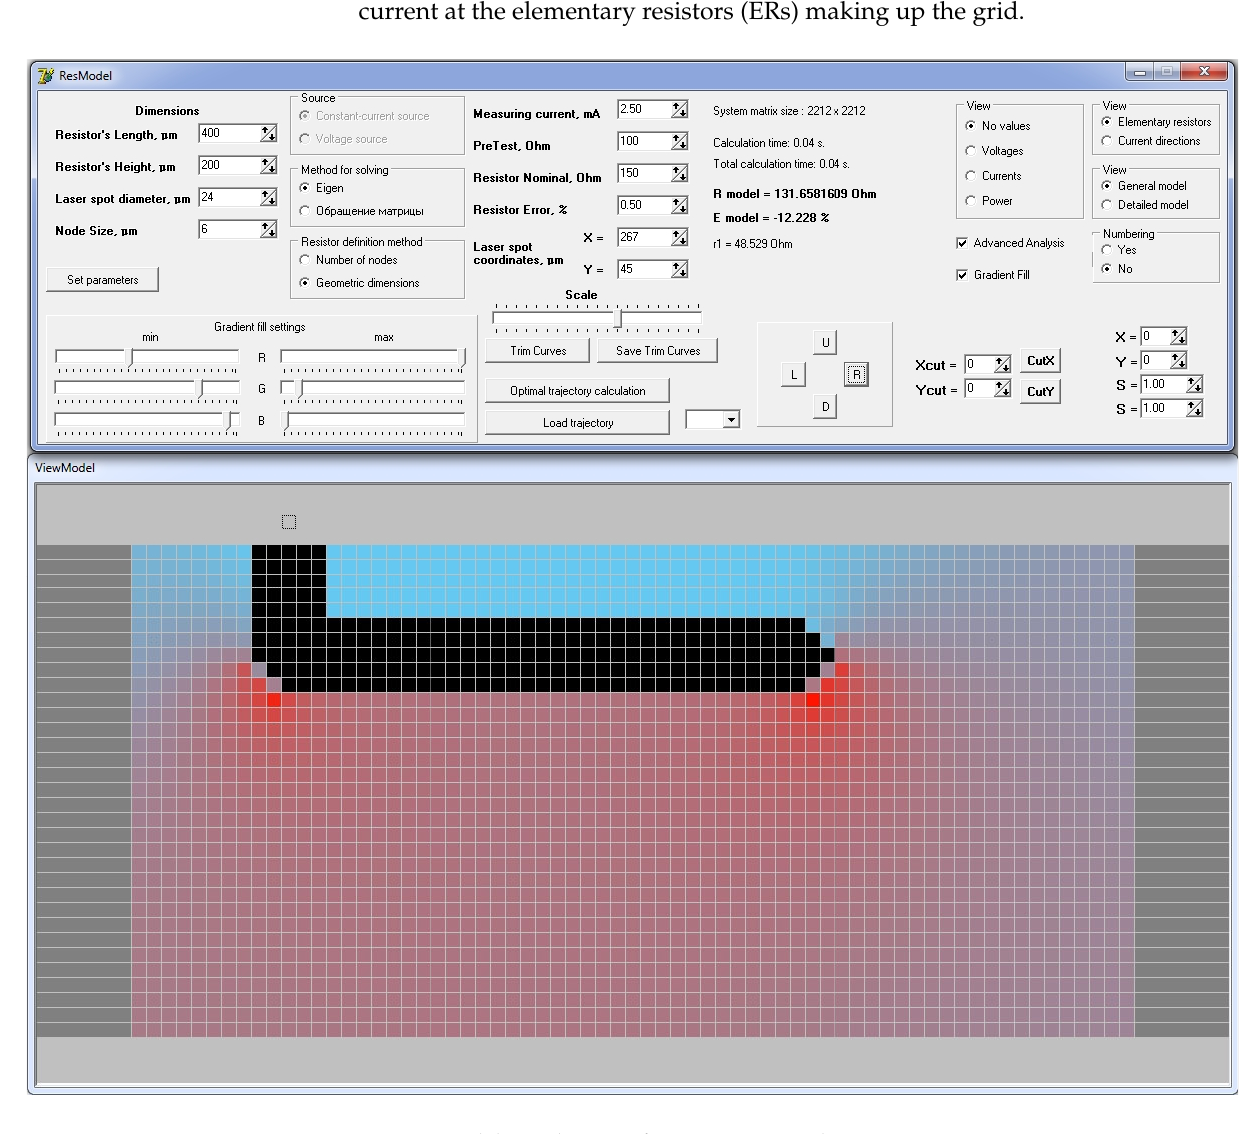
Figure 1. ResModel simulation software. Main window.